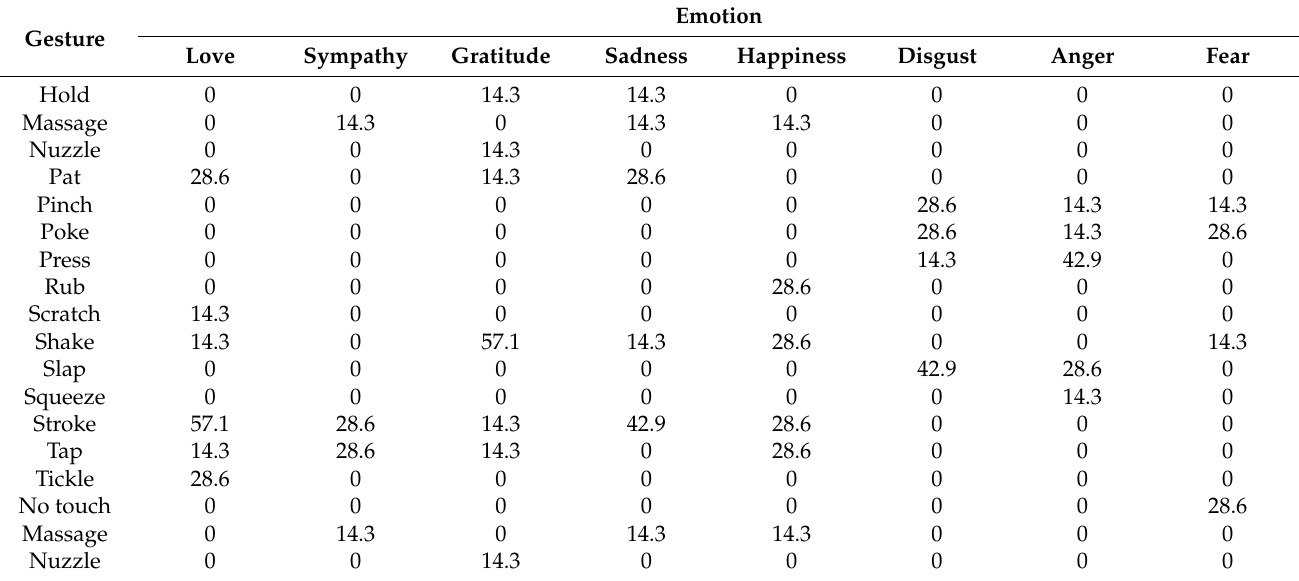
Table 3. Percentage: touch gestures participants use in each emotion (unit: %).